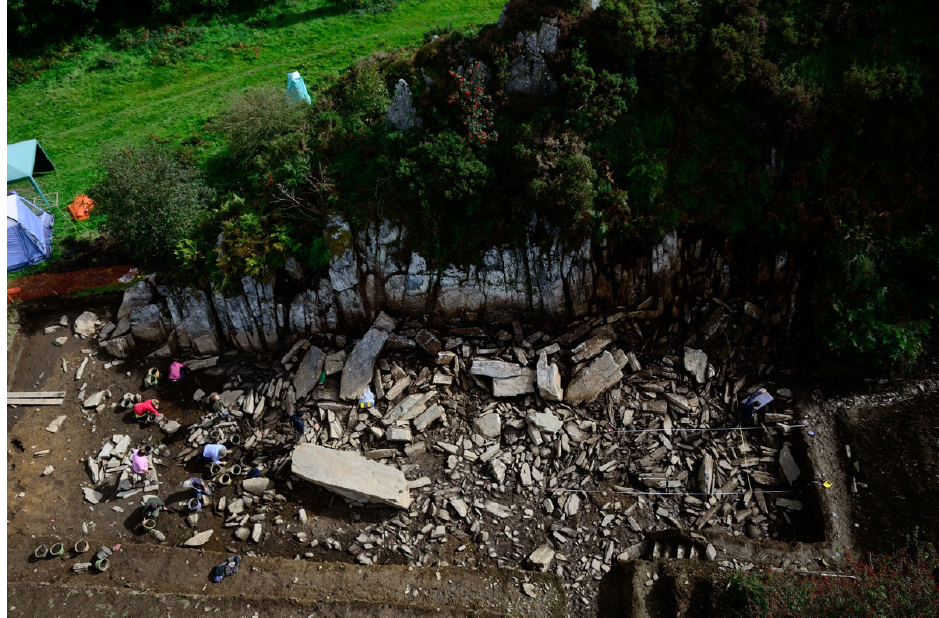
Fig. 7: Excavation of the Craig Rhos-y-felin rhyolite monolith quarry in Pembrokeshire, Wales (photo: Adam